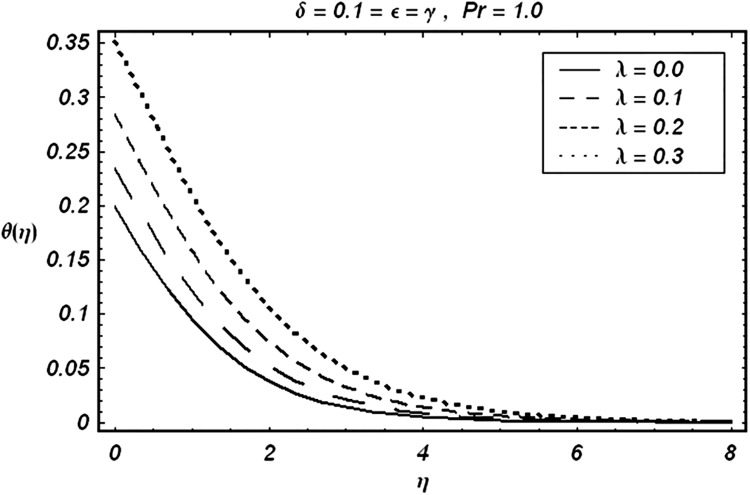
Variation of (λ>0) on θ.